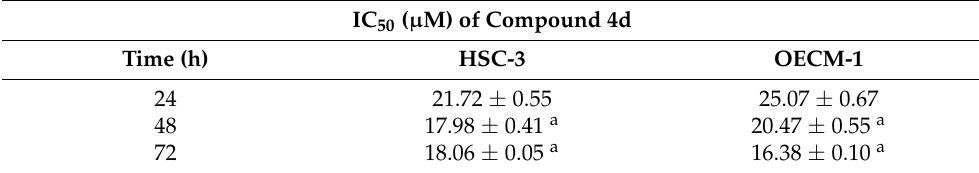
Figure 6. Cytotoxicity effect of pterostilbene and compound 4d. HSC-3 and OECM-1 were treated by compound 4d and pterostilbene with 0 (DMSO control), 1, 10, and 25 µ M for 24 h. Cytotoxicity was measured by MTT assay. Statistically significant differences are indicated as follows: ** p < 0.01, *** p < 0.001 between each group and vehicle control. Table 2. In vitro IC 50 values ( µ M) of compound 4 at 24, 48, and 72 h after